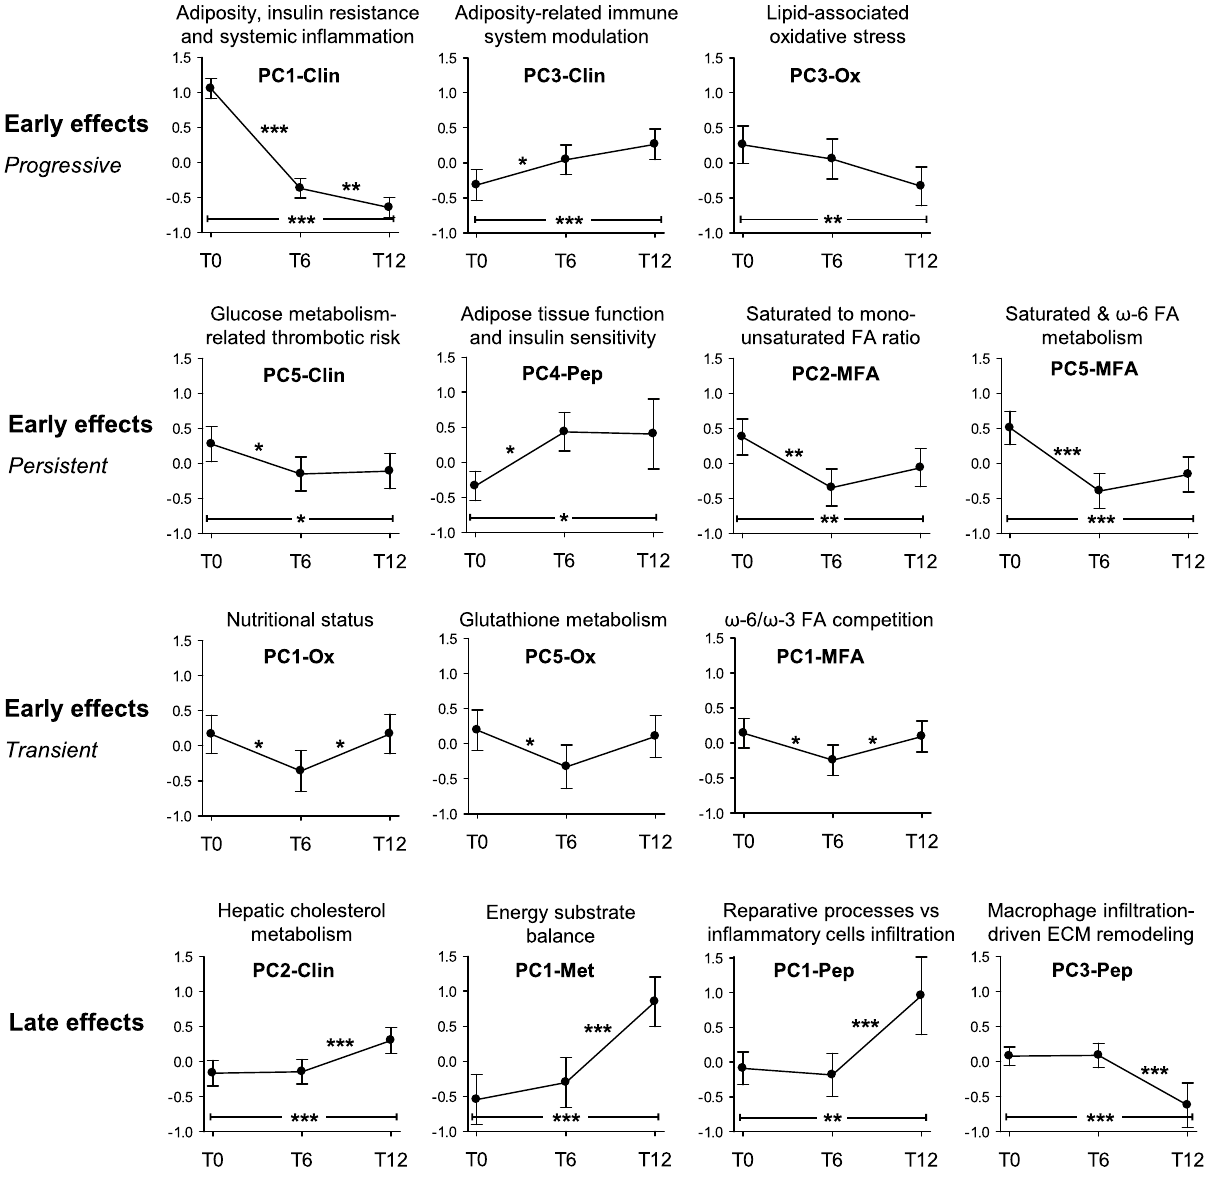
Figure 3. Early and late effects of bariatric surgery as assessed by PCs temporal trends. PC values at baseline (T0), six (T6) and twelve (T12) months from BS are reported. Values are means with 95% CI. *p ≤ 0.05; **p ≤ 0.01; ***p ≤ 0.001, repeated measures ANOVA with contrasts. ECM extracellular